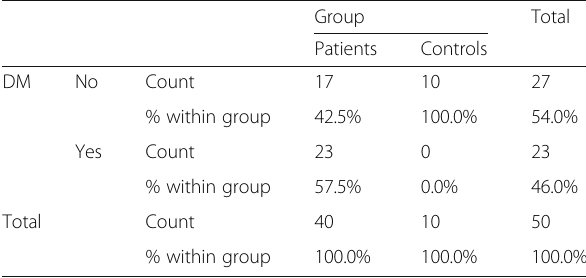
Table 2 Comparison of the studied groups regarding the history of DM